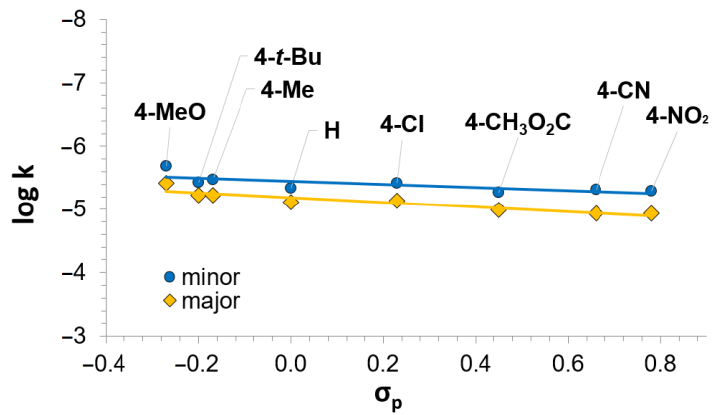
Figure 2. Plot of log k versus the Hammett constants (σ p ).